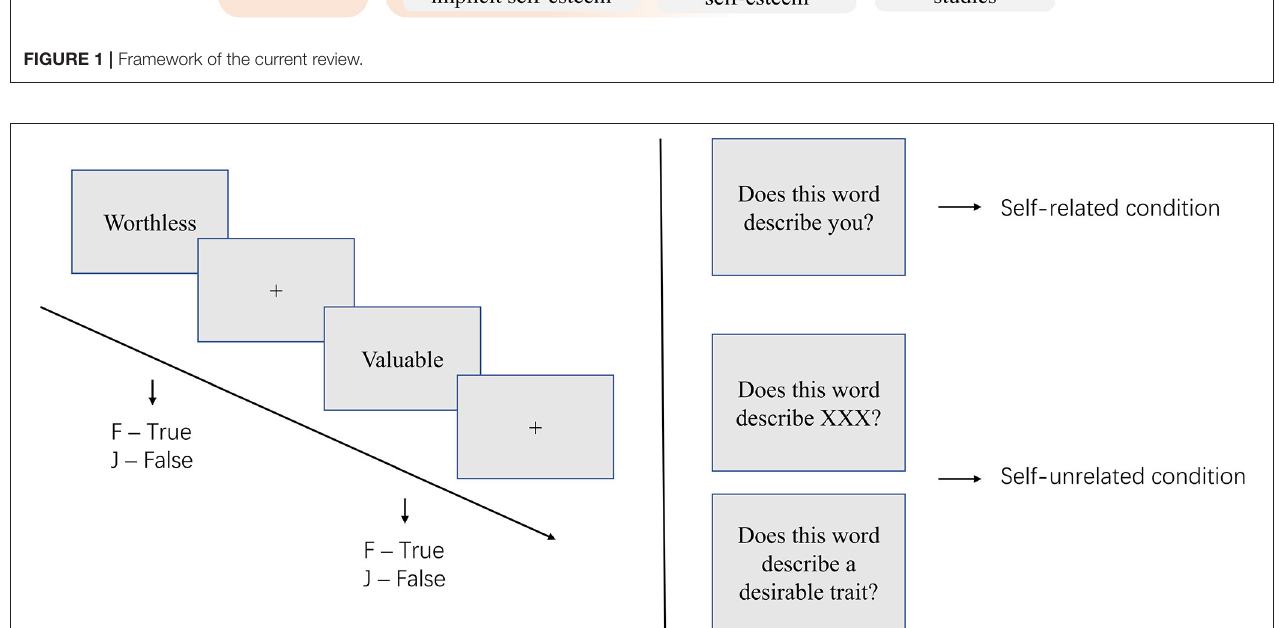
FIGURE 2 | Illustration of the self-referential encoding task (SRET).